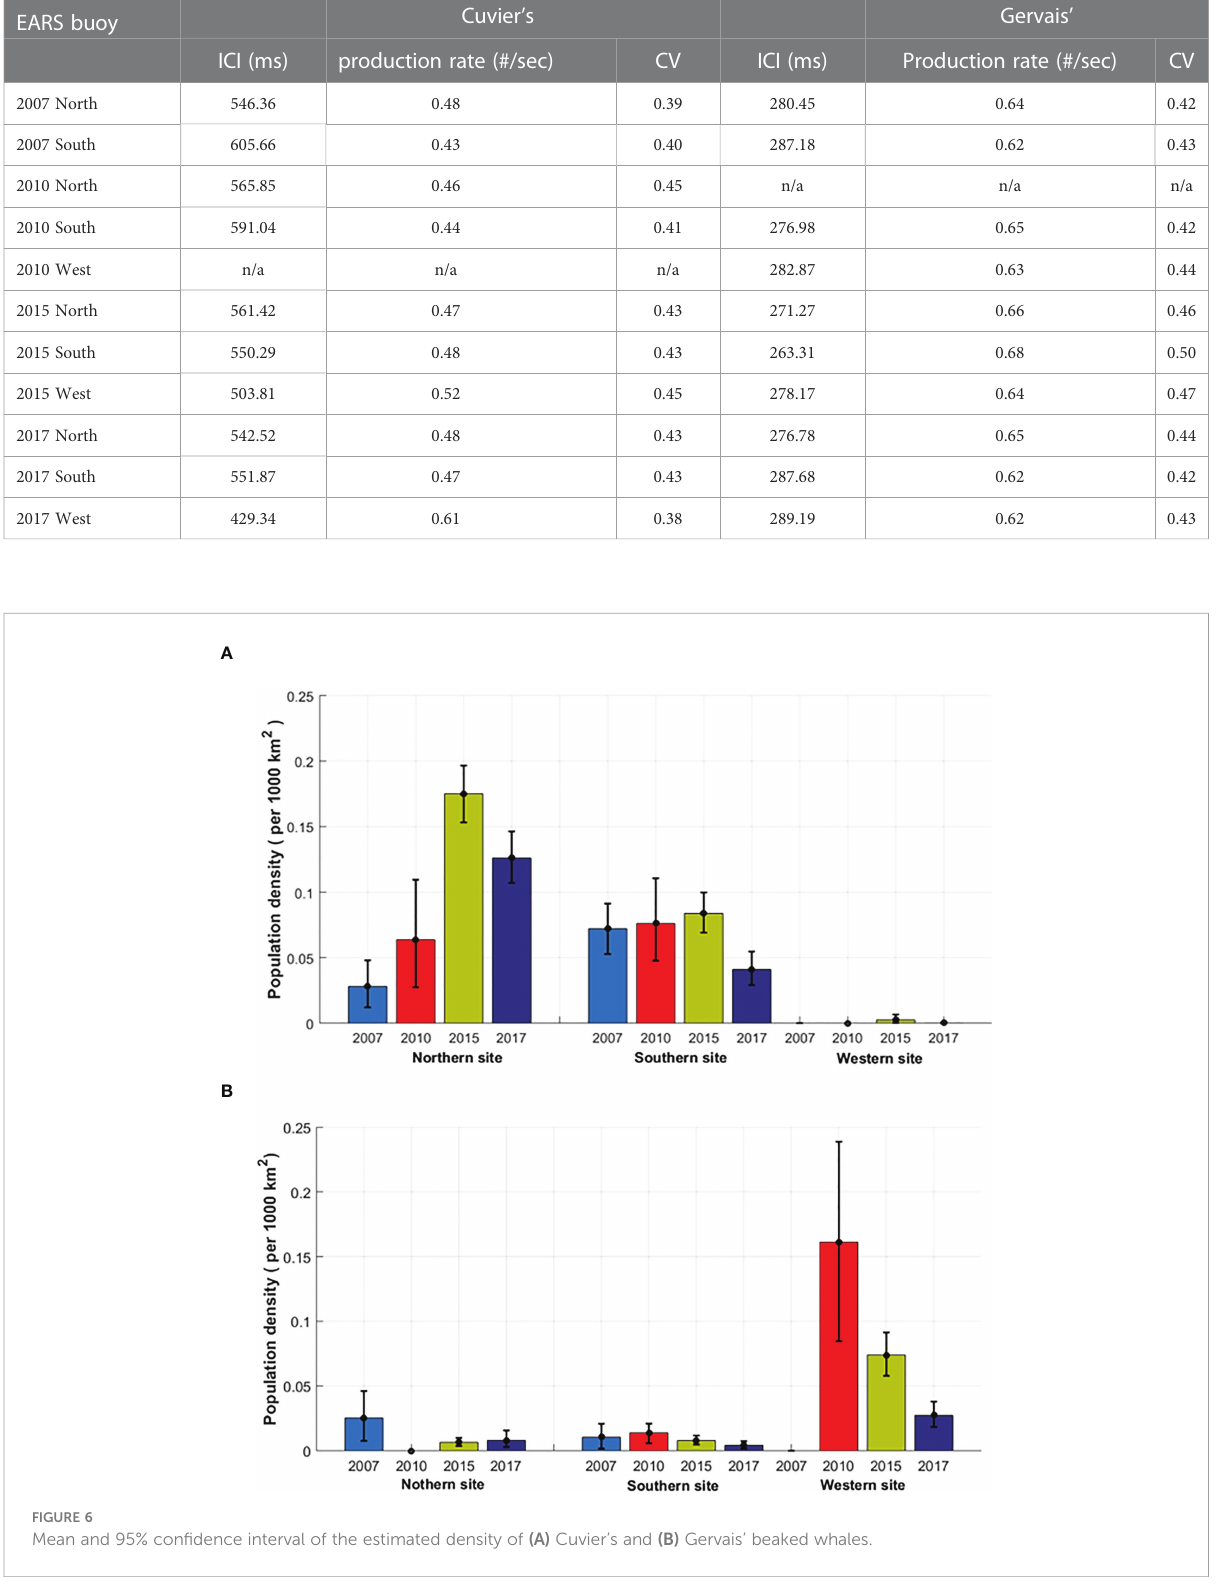
TABLE 5 Estimated mean inter-click interval (ICI), click production rates and coef fi cients of variation (CV) for Cuvier ’ s and Gervais ’ beaked whales for each dataset. EARS buoy Cuvier